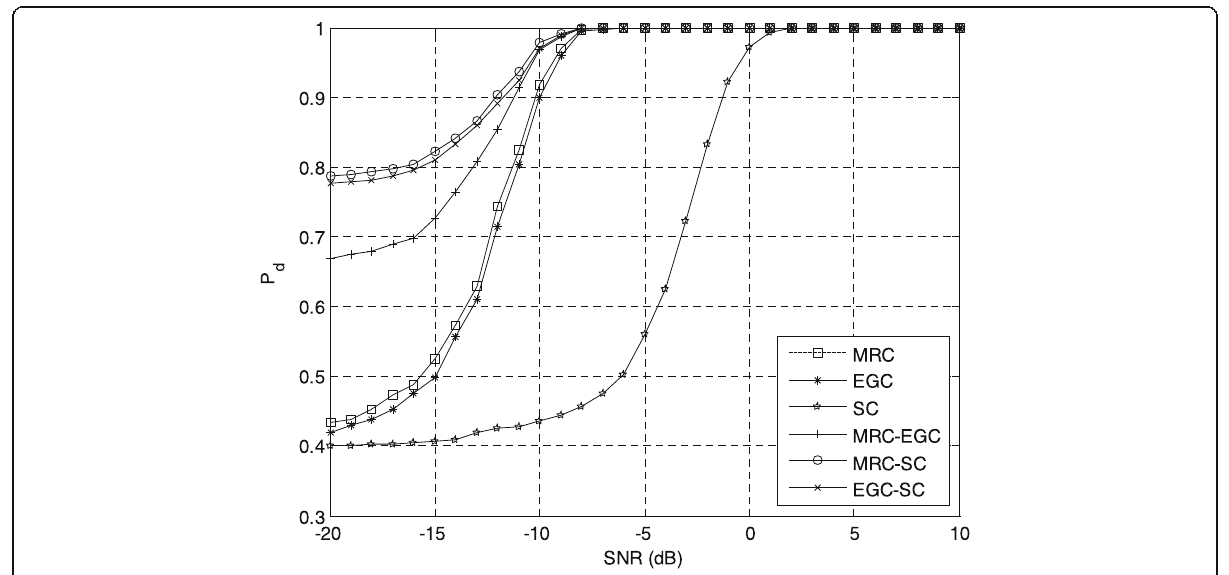
Fig. 12 Performance comparison of combination methods MRC-SC, EGC-SC, MRC-EGC, and single algorithms when P f =